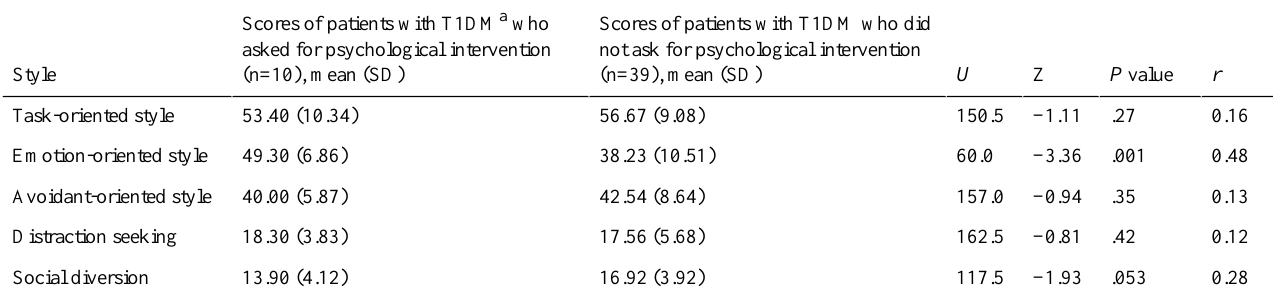
Table 3. Styles of coping with stress in the examined